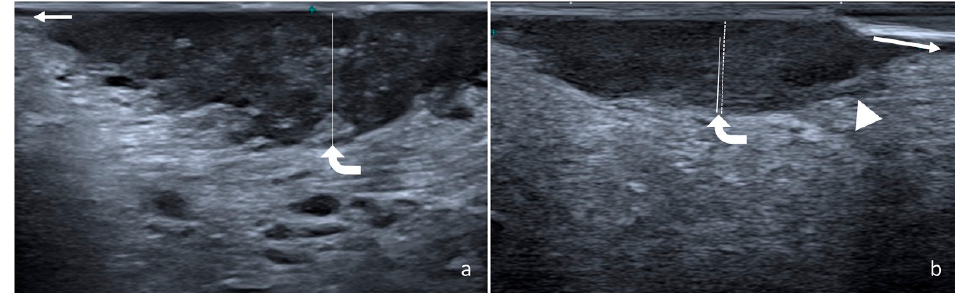
Figure 2. Two cases of squamous cell carcinoma of the lateral surface of the tongue. Flat ( a ) and exophytic ( b) lesions are shown. In each image, DOI (solid line) was measured perpendicularly from the mucosal surface to the deepest point of infiltration (curved arrow) using the closest normal mucosa as reference line (arrow). The exophytic portion of lesions ( b ) was not included and consequently DOI (solid line) and tumor thickness (dashed line) were significantly different. Arrowhead: superior longitudinal muscle.